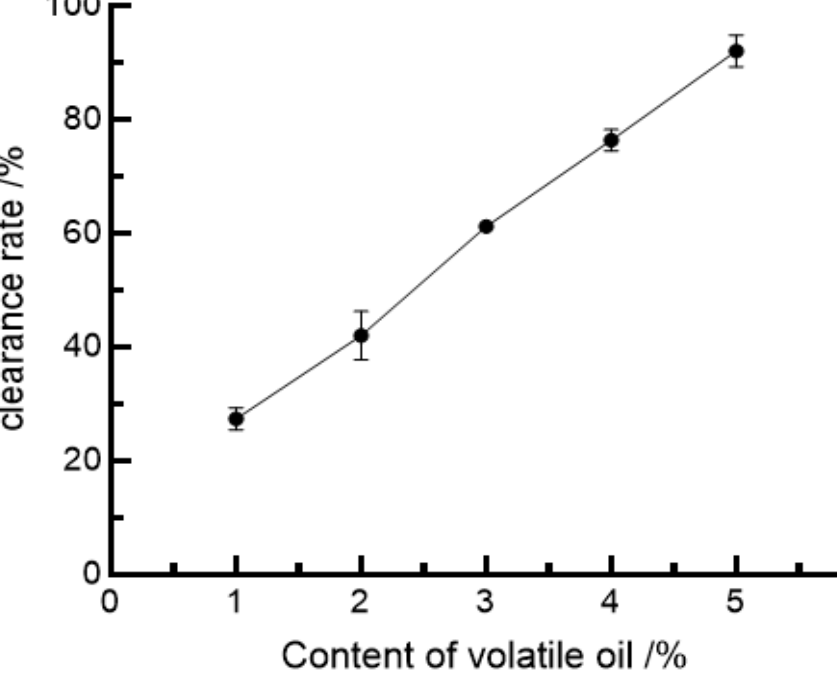
Figure 3. ABTS + • scavenging activity of Allium tenuissimum L. flowers essential oil.